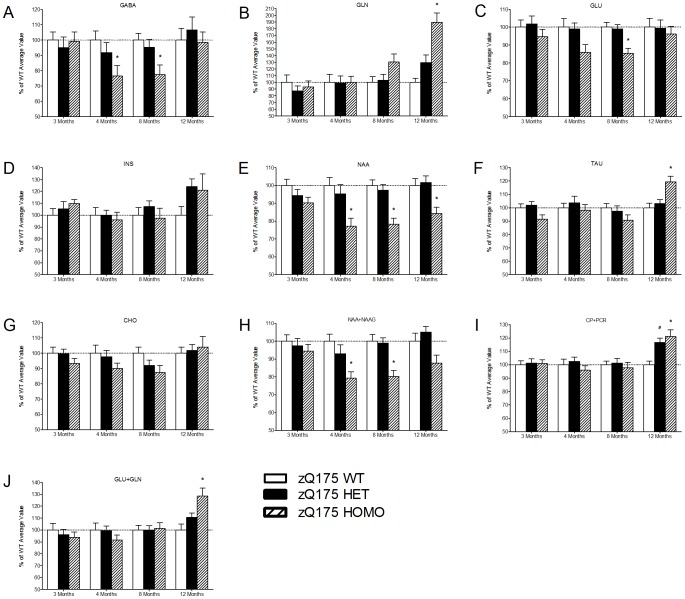
The percent changes of 1H MRS metabolites in the striatum of zQ175 mice.Longitudinal changes of individual 1H MRS observed metabolites in the striatum as given normalized to values obtained from WT control group at each time point. The striatal concentrations are presented for (A) GABA, gamma-aminobutyric acid, (B) GLN, glutamine, (C) GLU, glutamate, (D) INS, myo-inositol, (E) NAA, N-acetylaspartate, (F) TAU, taurine, (G) CHO, choline, (H) NAA+NAAG, N-acetylaspartate+N-acetylaspartylglutamate, (I) CR+PCR, creatine+phosphocreatine and (J) GLU+GLN, glutamate+glutamine. Data are presented as mean ± SEM. * p<0.05 zQ175 HOMO mice vs. zQ175 WT mice; # p<0.05 zQ175 HET mice vs. zQ175 WT mice (zQ175 WT, n = 10; zQ175 HET, n = 10; zQ175 HOMO, n = 9).